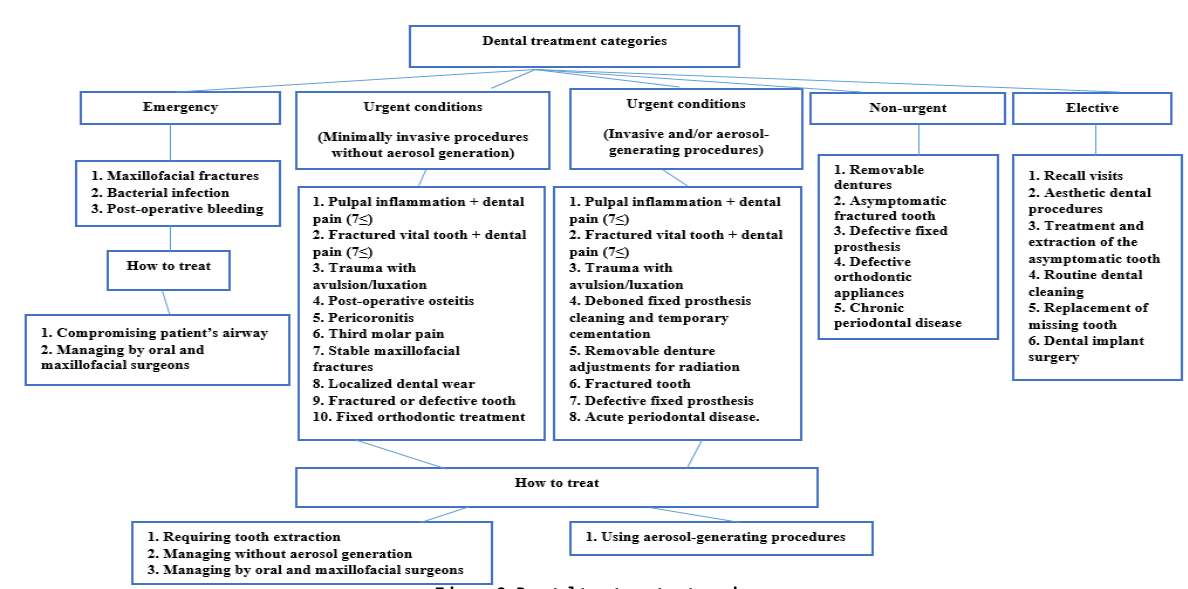
Figure 2. Dental treatment